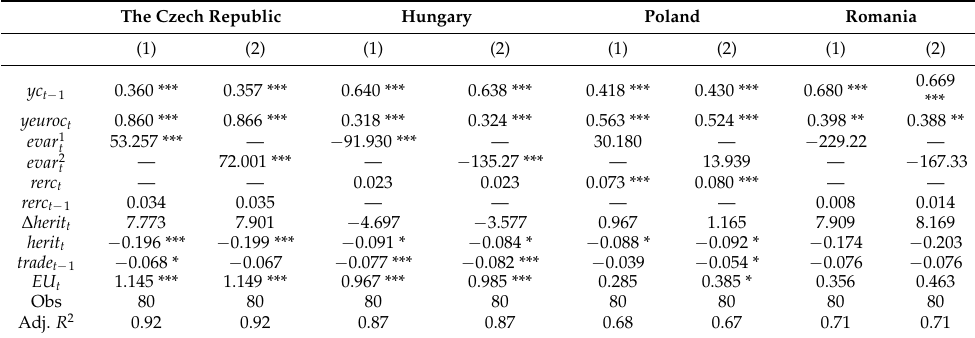
Table 5. Regression results for cyclical components of output (baseline